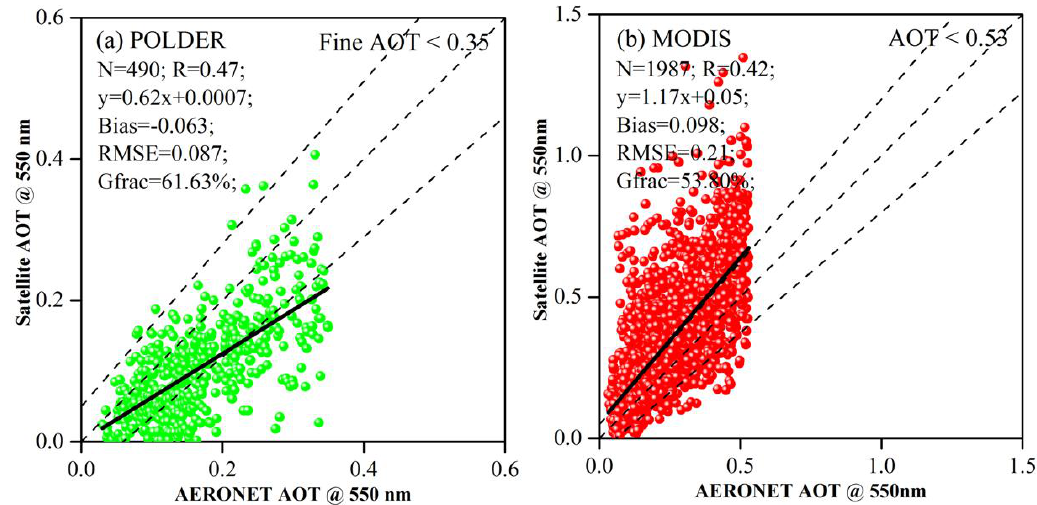
Figure 7. Scatter plots for the MODIS AOTs ( a ) and POLDER fine-AOTs ( b ) under the low aerosol loading